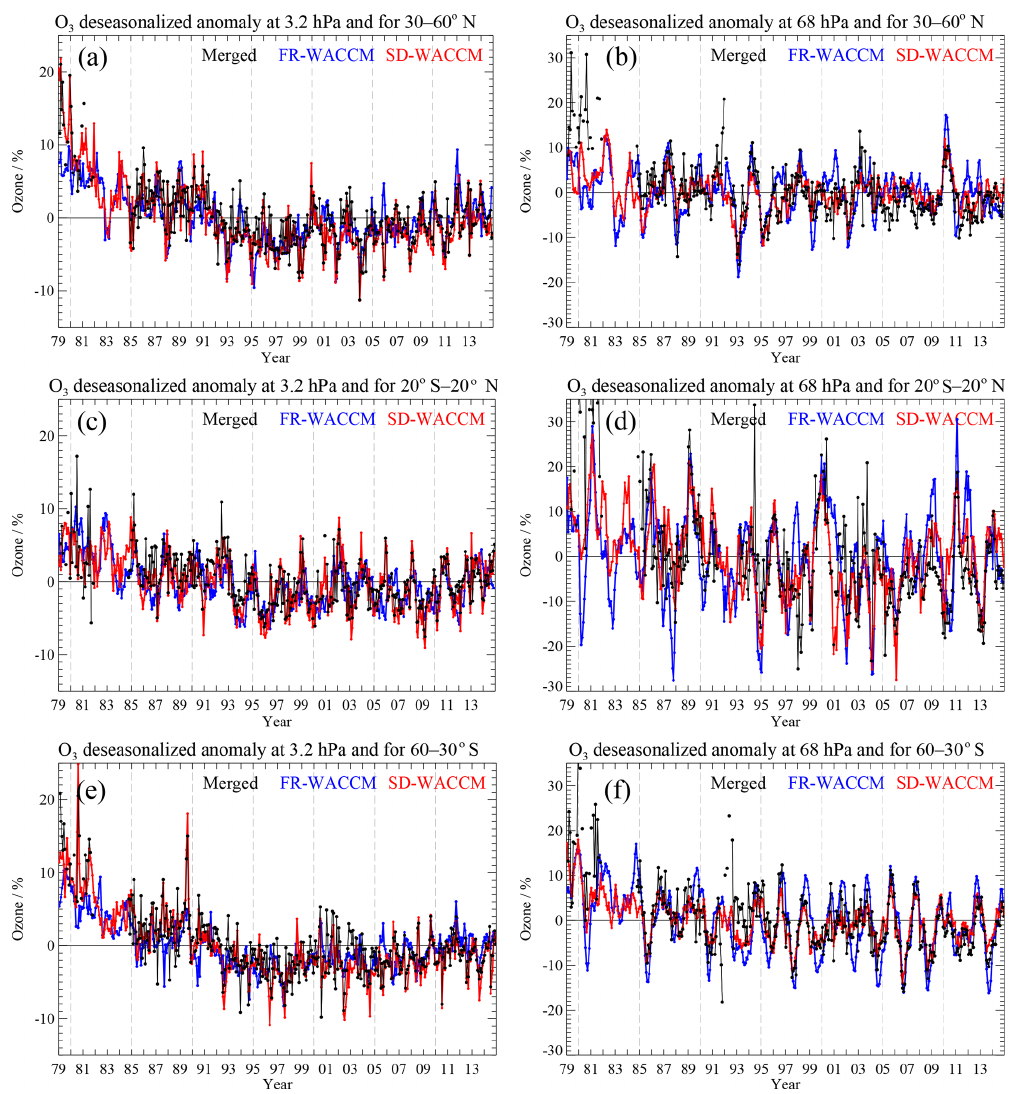
Figure 18. Sample time series of deseasonalized ozone anomalies (%) from 1979 through 2014 from the GOZCARDS data record (version 2.20) compared to the corresponding model anomalies from FR-WACCM (blue) and SD-WACCM (red). Upper-stratospheric series at 3.2hPa are shown in (a, c, e) and lower-stratospheric series at 68hPa in (b, d, f) ; three latitude bins are displayed (30–60 ◦ N, a, b ; 20 ◦ S–20 ◦ N, c, d ; and 30–60 ◦ S, e, f